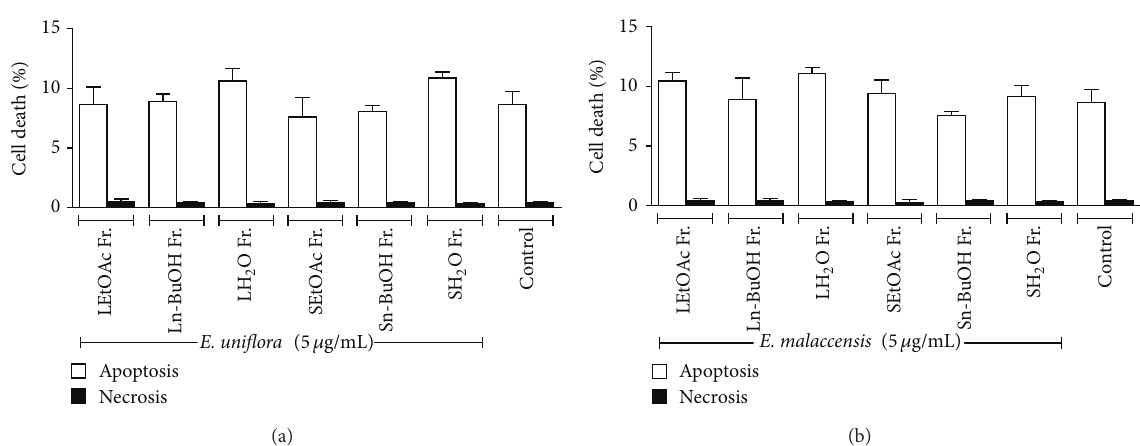
Figure 2: Percentage of apoptotic cells and necrotic cells treated with extracts from E. uniflora (a) and E. malaccensis (b). Values are given as mean ± SD ( 𝑛 = 4 ). Ethyl acetate fraction of leaves (LEtOAc Fr.), butanol fraction of leaves. (Ln-BuOH Fr.), aqueous fraction of leaves (LH 2 O Fr.), ethyl acetate fraction of seeds (SEtOAc Fr), butanol fraction of seeds (Sn-BuOH Fr.), and aqueous fraction of seeds (SH 2 O Fr.).